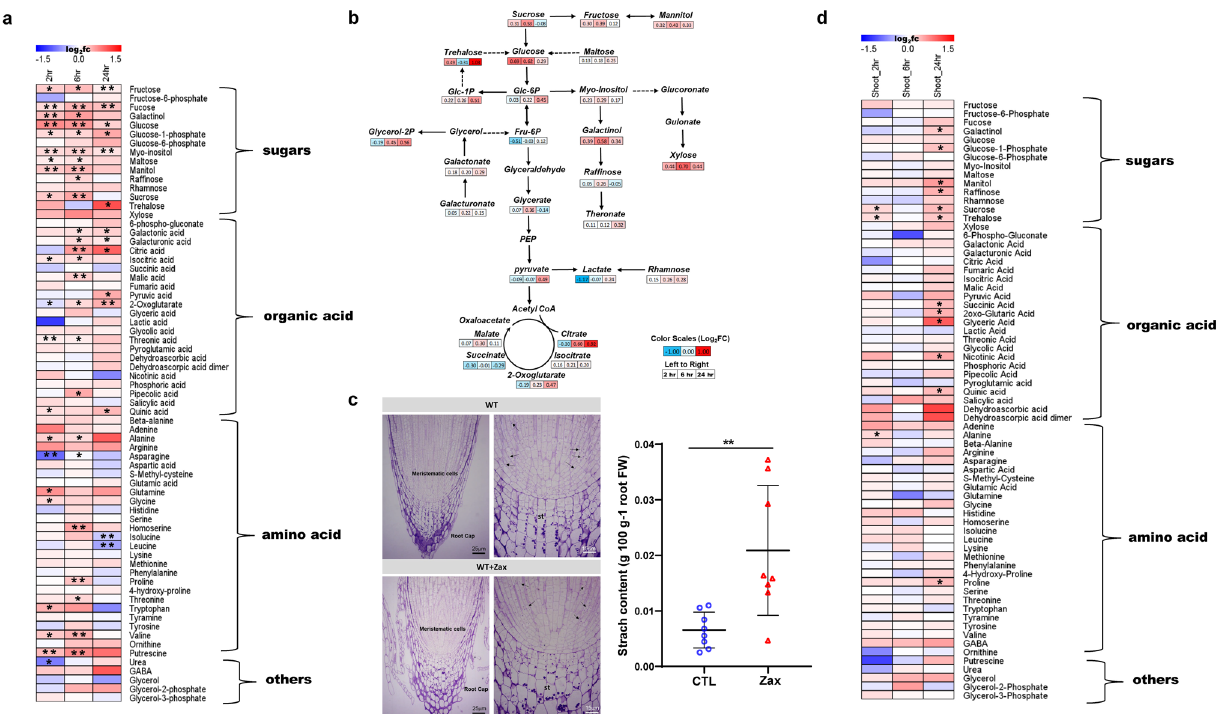
Fig. 1 The dynamic primary metabolite pro fi les upon zaxinone treatment. Primary metabolites extracted from roots for GC – MS, which were annotated and listed in Supplementary Data 6. Three independent harvests were concurrently subjected to GC – MS analysis. n ≥ 4 biological replicates. a Heatmap of root tissue showing relative accumulation of each metabolite as compared to those in control plants. For each metabolite, the value of the corresponding wild type was set to 1. Asterisks indicate statistically signi fi cant differences as compared to control by t -test (* p < 0.05, ** p < 0.01). b The scheme of major metabolic changes in the sugar-related metabolites after zaxinone treatment, which adapted from a . Blue and red color depict a decrease and increase in metabolic levels compared to the non-treated root samples, respectively. The data are presented as log2 (fold changes) from left to right as follows: 2, 6, and 24 h. c Longitudinal-sections of WT and WT treated with 5 µ M zaxinone roots tips after resin-embedding and staining by the Periodic Acid-Schiff (PAS) reaction for the visualization of amyloplasts. At higher magni fi cation (15 µ m) the statoliths (st) in the root cap, as well as some tiny amyloplasts (arrows), are present in the cytoplasm of meristematic cells. The starch level was quanti fi ed in the root tissues. Bar presented as mean ± SD, n = 8 biological replicates. d Heatmap of shoot tissue of relative accumulated metabolites in comparison with control. For each metabolite, the value of the corresponding wild type was set to 1. Asterisks indicate statistically signi fi cant differences as compared to wild type by t -test (* p < 0.05, ** p < 0.01). CTL control, Zax